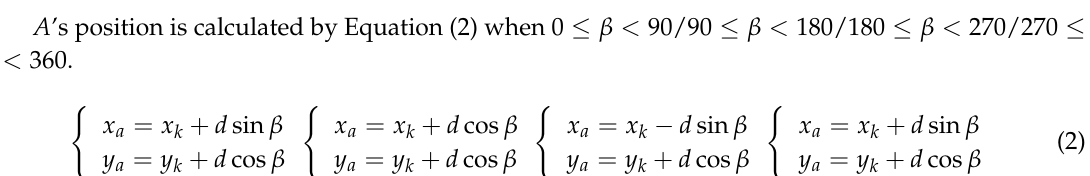
Figure 4. Relative position of A and K .